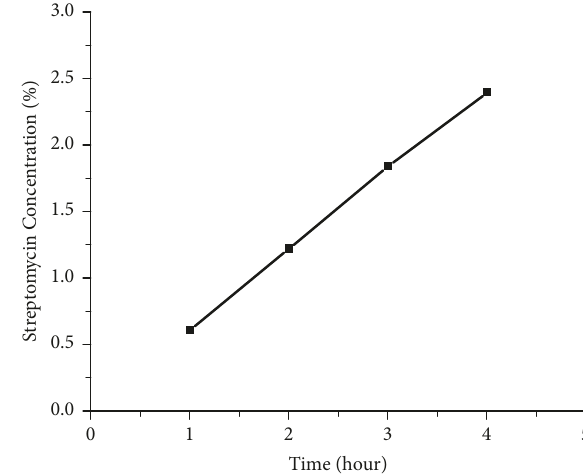
Figure 11: The streptomycin release profile overtime from the IBS- injected bone